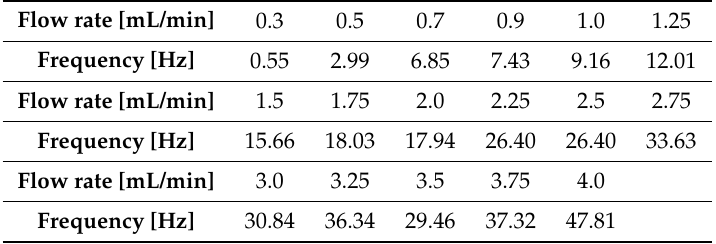
Figure 2. For the experiment with V = 0.3 mL/min: (at the top ) the trend of the optical signal after filtering and (at the bottom ) its spectrum. Table 1. Experimental campaign: Flow rate (mL/min) and Frequency peak